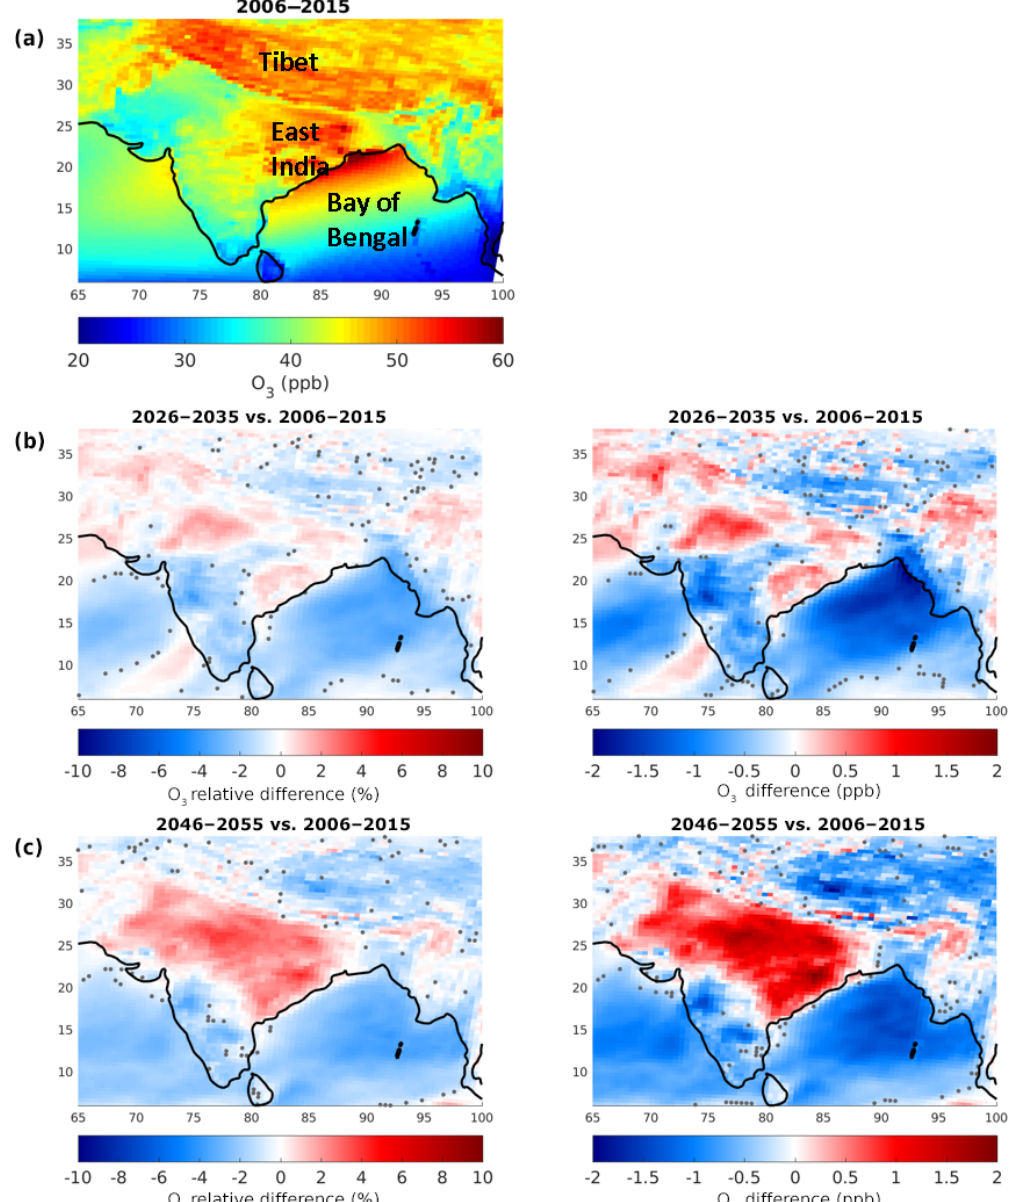
Figure 7. (a) Distribution of surface O 3 mixing ratios (in ppb) for the reference scenario. Distribution of the relative difference and absolute difference in surface O 3 between the reference scenario and the FC2030 scenario (b) and the FC2050 scenario (c) . The relative differences are calculated as ([FC – reference] / reference) × 100%, and the absolute differences as [FC – reference]. Grey dots mark grid points that do not satisfy the 95% level of